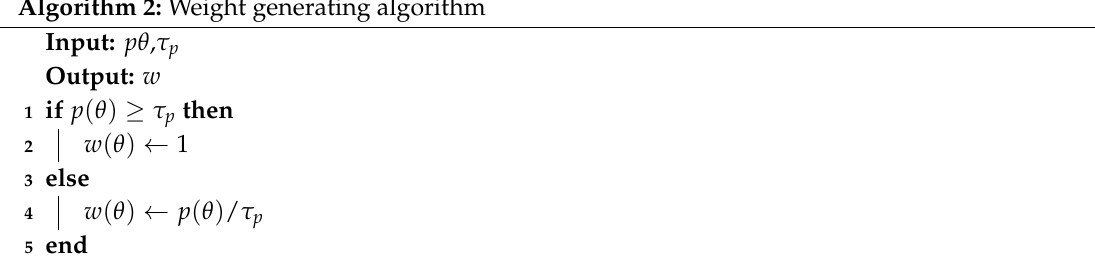
Algorithm 2: Weight generating